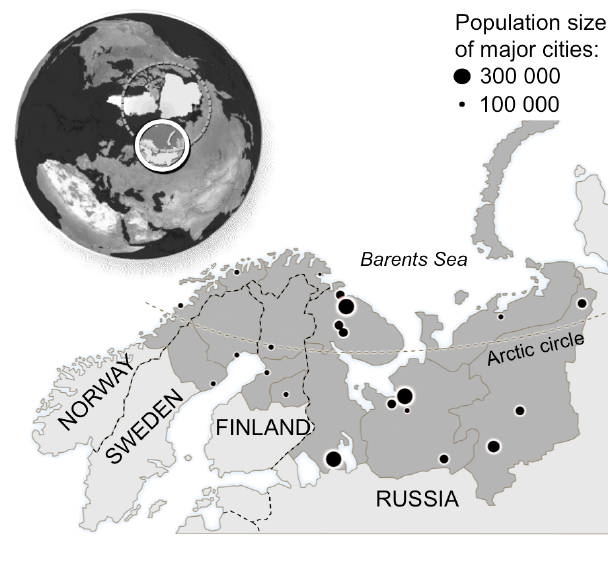
Fig. 1 . Map of the Barents Region (dark gray), consisting of northern Norway, Sweden, Finland, and northwestern Russia. Inset globe shows the position of the Barents Region (encircled) within the Northern